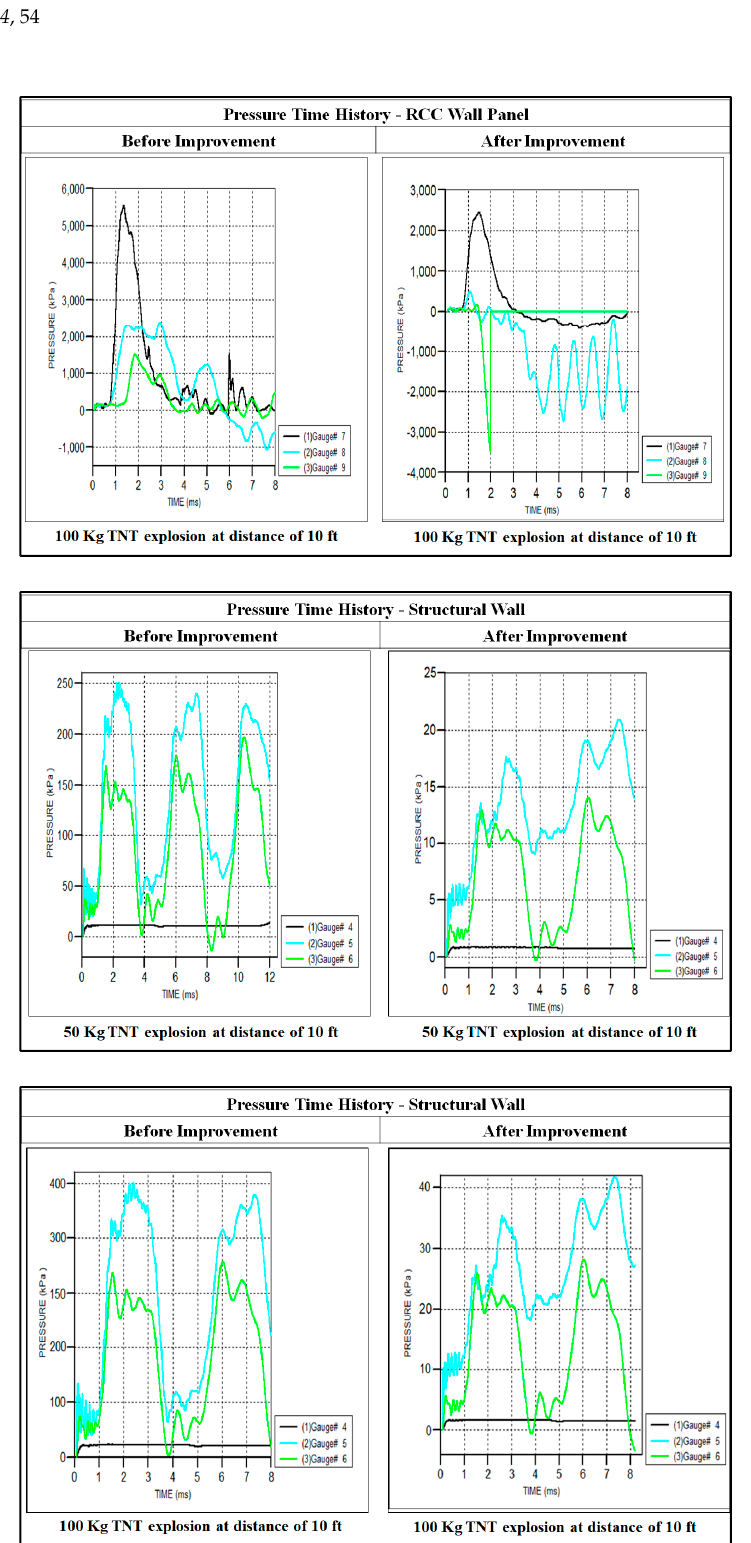
Figure 11. Comparison of TNT explosions at a distance of 10 ft from RCC wall panels.